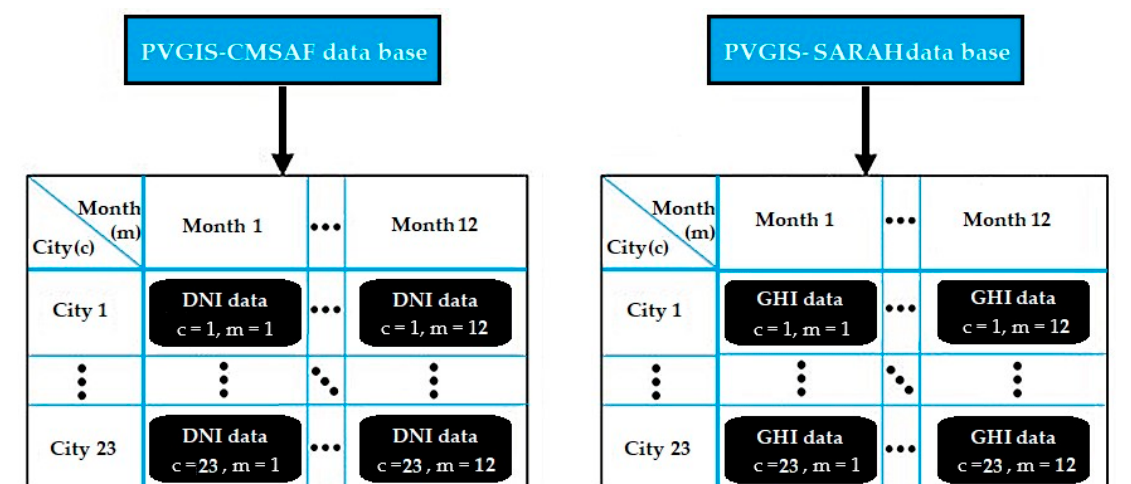
Figure 6. Categorization of the DNI and GHI data according to the month and considered city. Source: own elaboration.